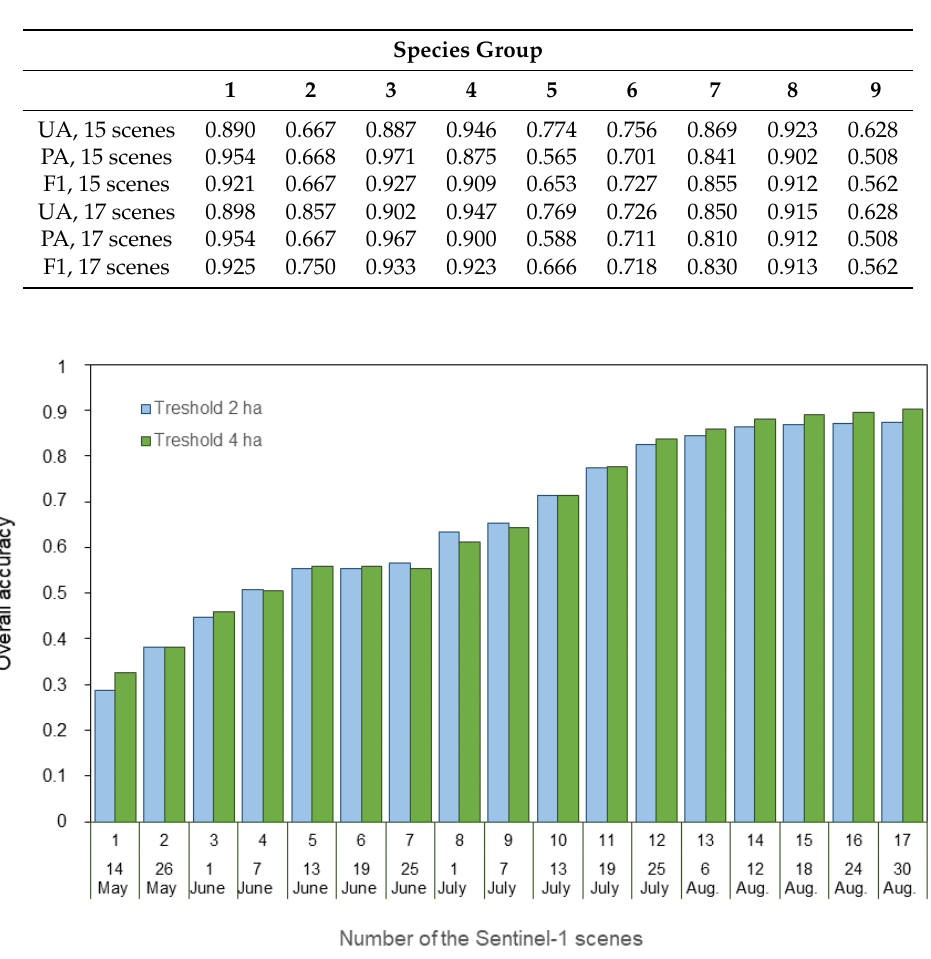
Figure 4. Overall accuracies as a function of the stage of the phenology and the number of scenes calculated with the minimum sizes of the parcels of two and four